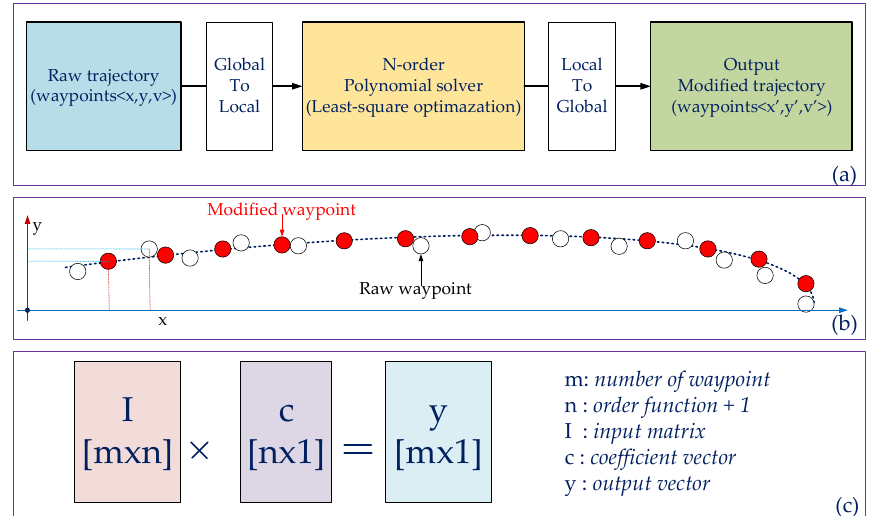
Figure A1. Smoother trajectory using n-order polynomial function based on least square optimization. ( a ) The overview of the smoother path algorithm, <x,y> is the coordinate of a point in the global frame, v is the velocity of the vehicle. ( b ) the waypoints before and after operating the smoother algorithm. ( c ) The dimension of matrices in the least square